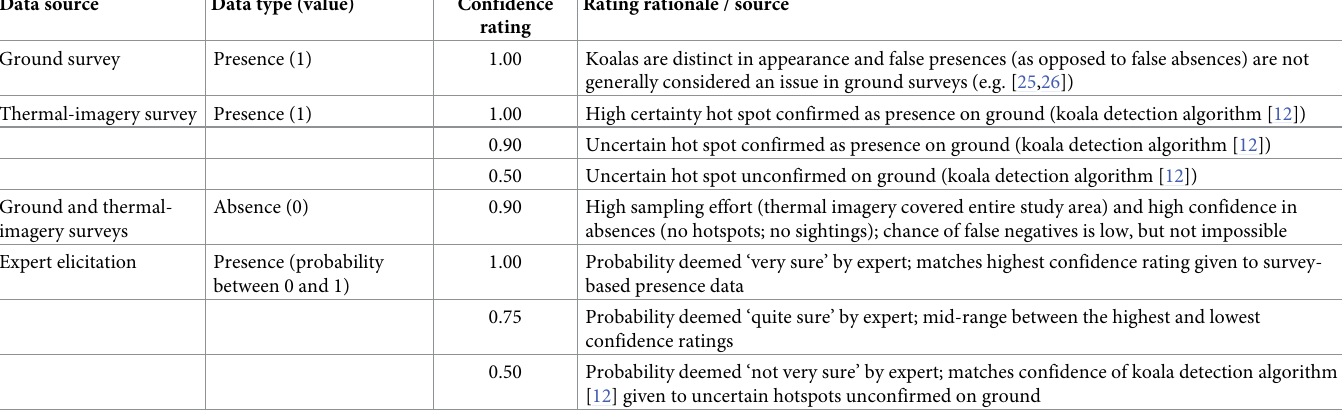
Table 1. Confidence